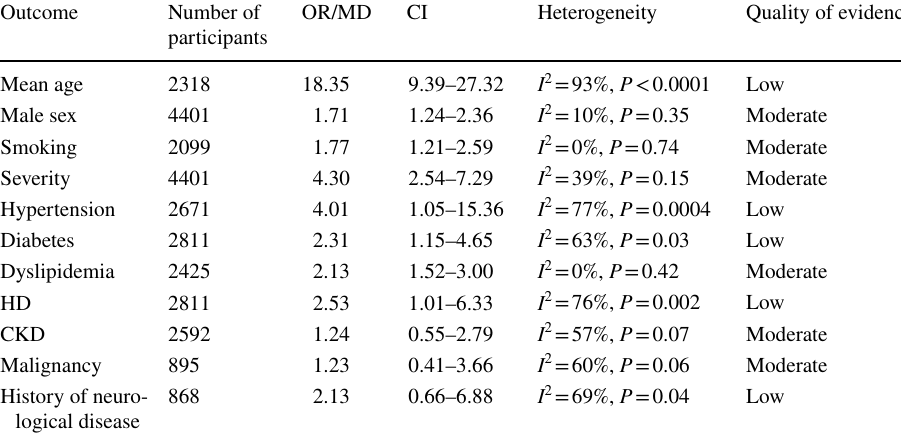
Table 2 Quality of evidence relating to outcome